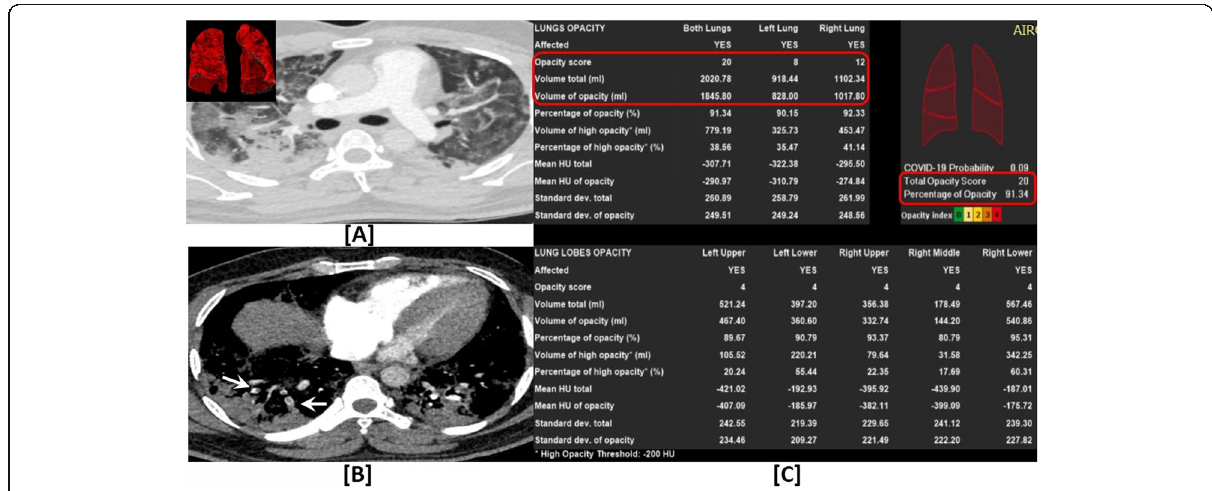
Fig. 5 A 34-year-old COVID-19 male patient with acute pulmonary embolism (PE) on a background of high total opacity score (TOS); a Axial lung window CTPA showing bilateral widespread large ground-glass opacities and consolidative changes. b Axial mediastinal window CTPA showing right lower lobar multiple segmental and sub-segmental acute pulmonary emboli (PE) (white arrows). c Detailed artificial intelligence quantitative assessment revealed: TOS = 20/20 and volumetric percentage =